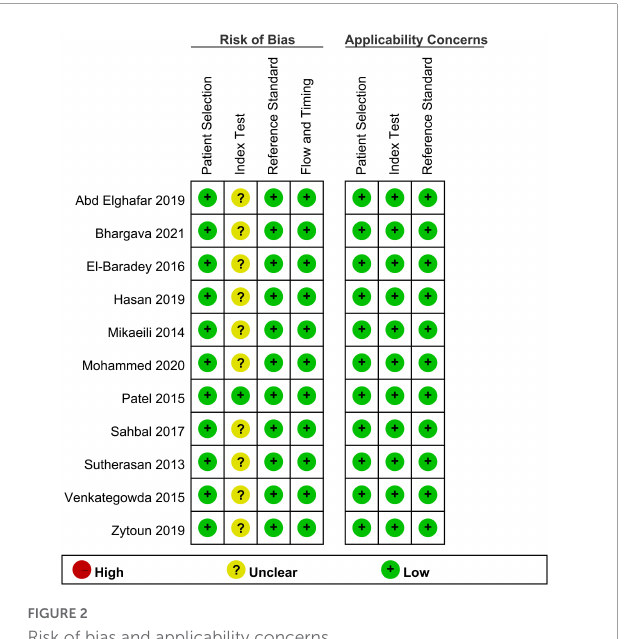
FIGURE2 Risk of bias and applicability concerns.